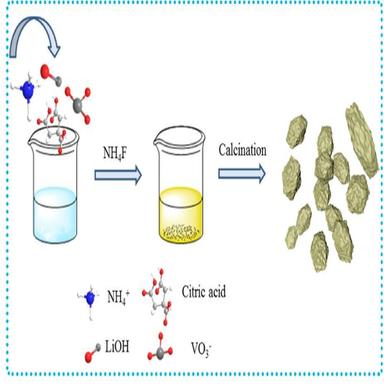
Preparation scheme for F doped Li3VO4.